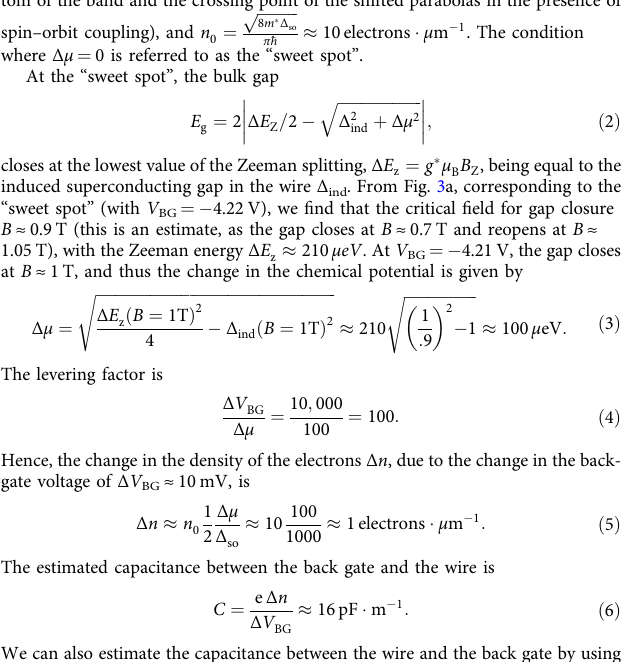
q(cid:3) (cid:3) (cid:3)